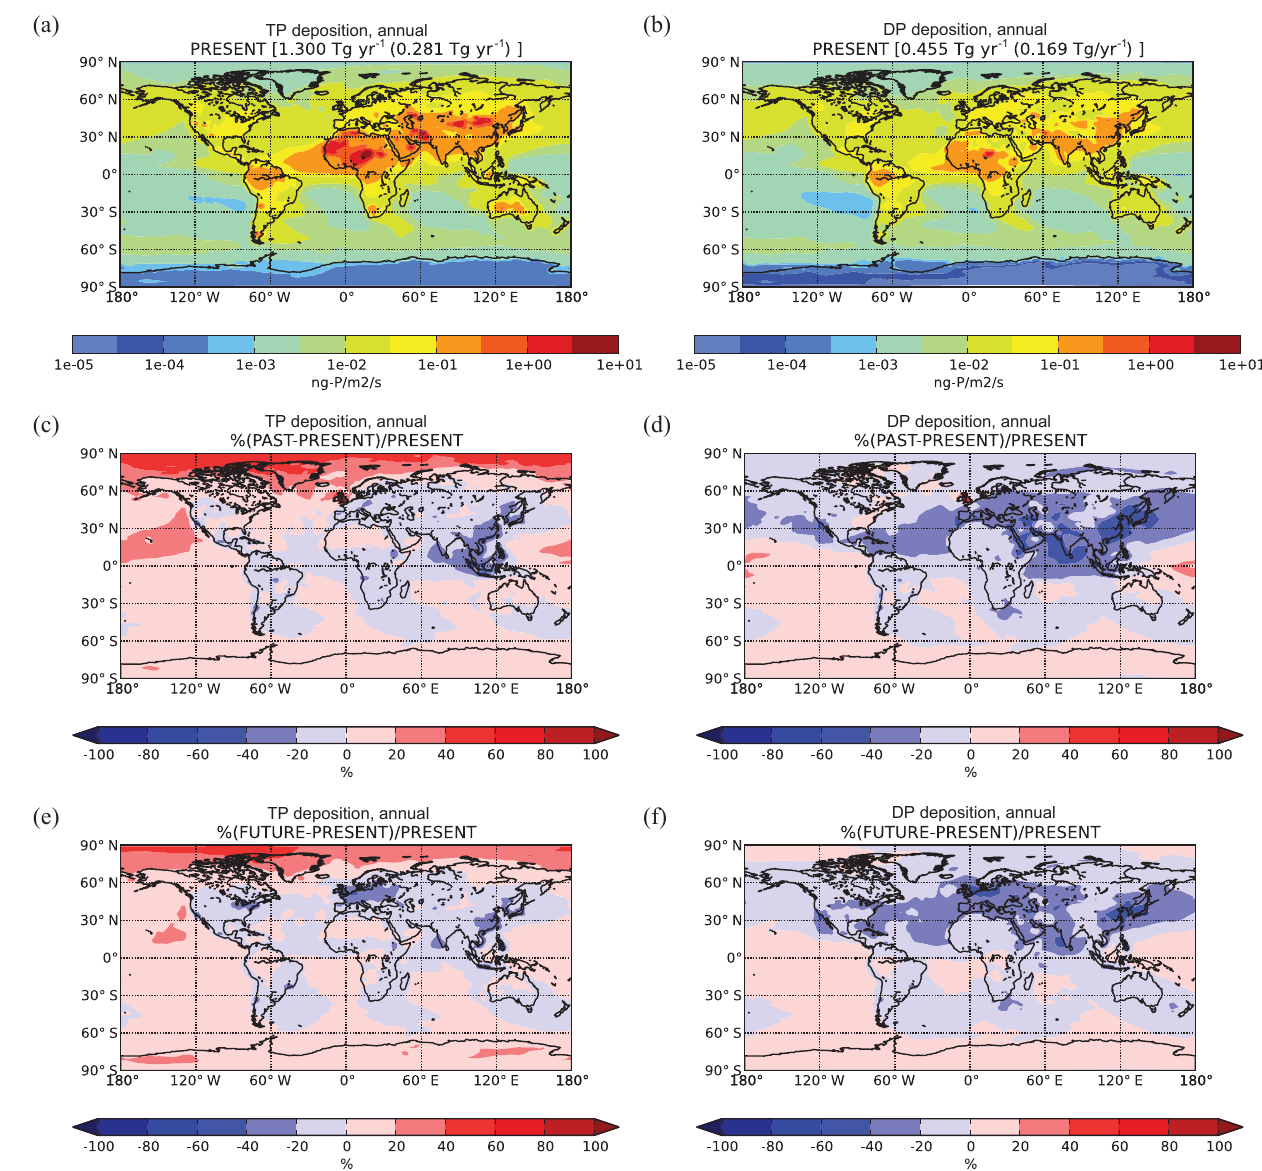
Figure 6. Calculated annual deposition fluxes (in ng-Pm − 2 s − 1 ) for (a) TP and (b) DP for PRESENT simulation and their percentage differences from PAST ( c , d ) and FUTURE ( e , f ) simulations, respectively. For the PRESENT annual deposition fluxes ( a , b ), within brackets, the total amounts over the globe (in parentheses only over the ocean) are also